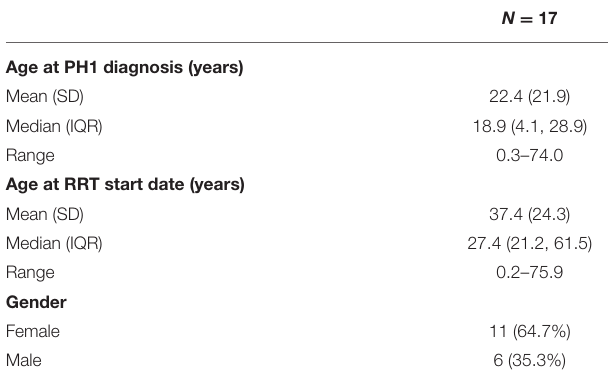
TABLE 1 | Investigations used to evaluate for oxalate deposition in specific tissues. Tissue